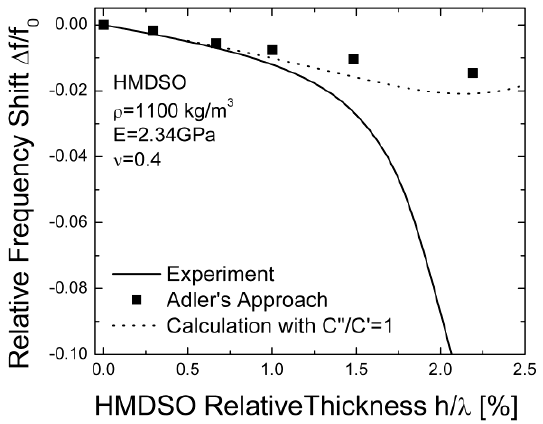
Figure 7. Theoretical vs. experimental mass